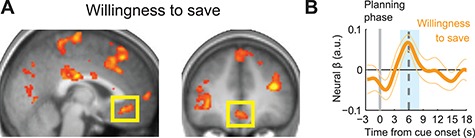
Activity in vmPFC during planning phase coding reported intentions expressed as WTS. A, Activity in vmPFC correlated with WTS ratings during the planning phase (n = 24; [−2, 34, −10], z = 3.68; P < 0.05, small volume correction on predefined coordinates). B, ROI analysis. Activity in vmPFC during the planning phase was related to WTS (random effects analysis; t(21) = 3.49, P = 0.002; data for this ROI analysis and all other ROI analyses were extracted from coordinates defined by leave-one-subject-out cross-validation). Neural β indicates mean regression weight from fitting a linear regression model with WTS as regressor to neural activity in each subject. Thin colored lines indicate SEM across subjects. ‘Planning phase’ indicates onset of planning phase (at 0 s). The blue shaded box indicates the analysis period at the expected delay of the hemodynamic response.